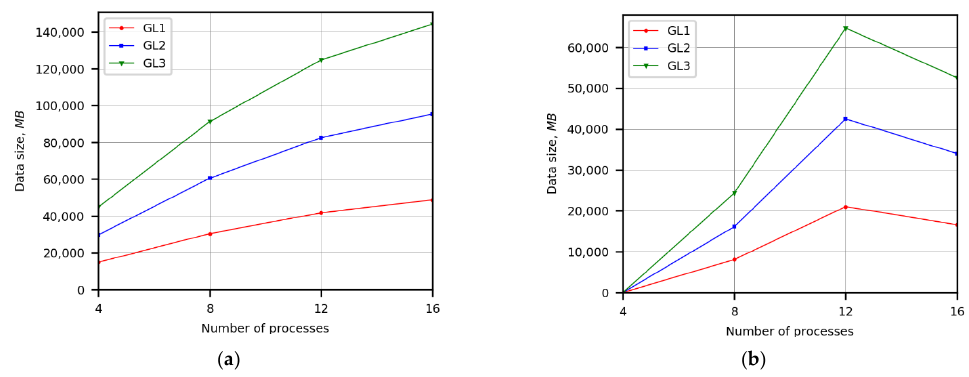
Figure 4. Communication: data transferred between ( a ) cores and ( b ) nodes.